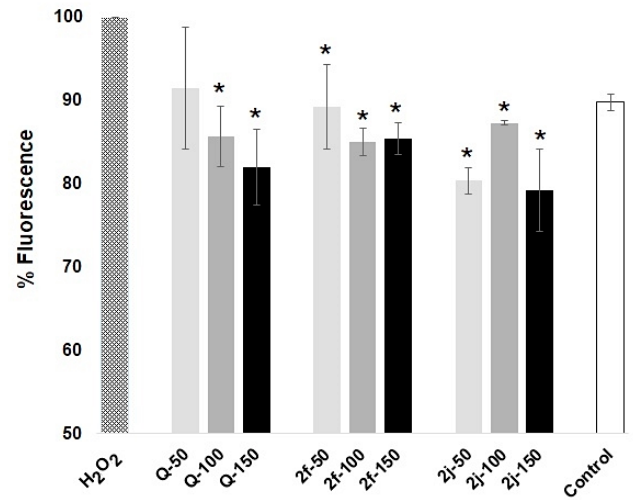
Figure 4. Fluorescence intensity of the ROS assay kit of 2f , 2j , and quercetin (50, 100, and 150 µM) in HeLa cells (means ± SD, n = 3). Data are presented as the mean ± SD for at least three independent experiments. Asterisks (*) indicate a significant difference ( p < 0.05) compared to the H 2 O 2 model group.